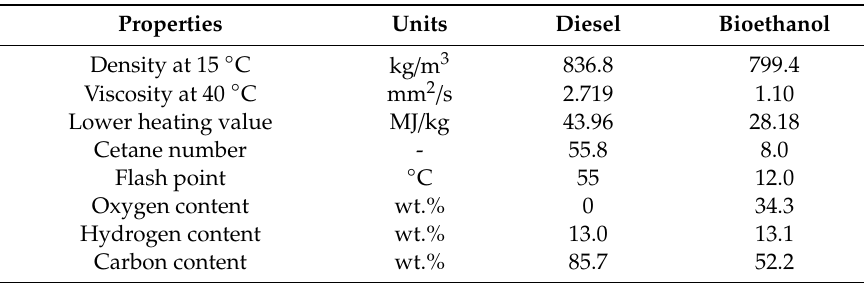
Table 1. Diesel and Bioethanol